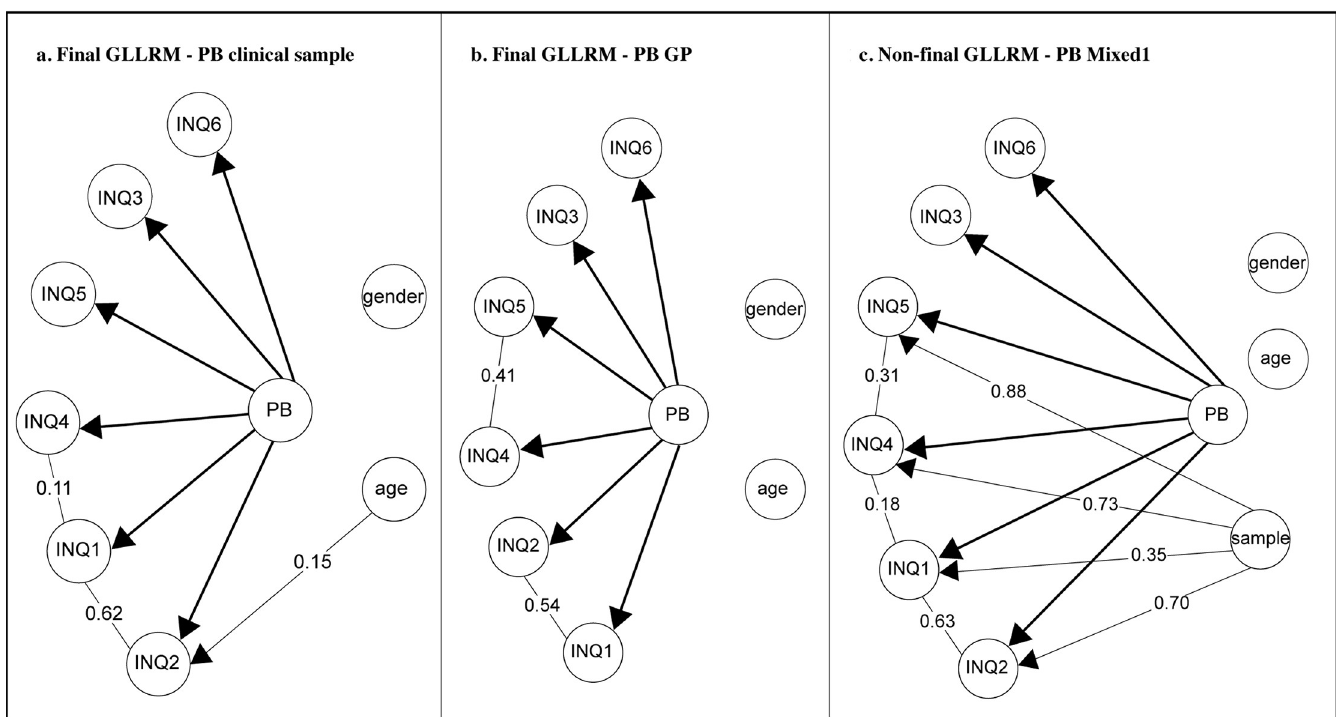
Fig 1. The graphical loglinear Rasch models for the PB-subscale. Lines between items show evidence of LD, arrows pointing from the exogeneous variables to the items evidence of DIF. γ -correlations are partial Goodman and Kruskal’s rank correlations for ordinal data.